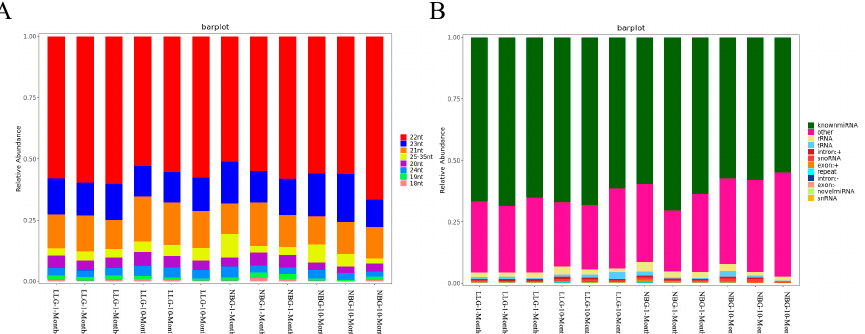
Figure 3. miRNA expression profiles in longissimus dorsi of goat. ( A ) Percentage distribution of all small RNA sequence lengths in longissimus dorsi of goat. ( B ) Characteristics of known and novel miRNAs in longissimus dorsi of goat. Small RNA classification was performed using the priority of “known miRNA > rRNA > tRNA > snRNA > snoRNA > repeat > gene > novel